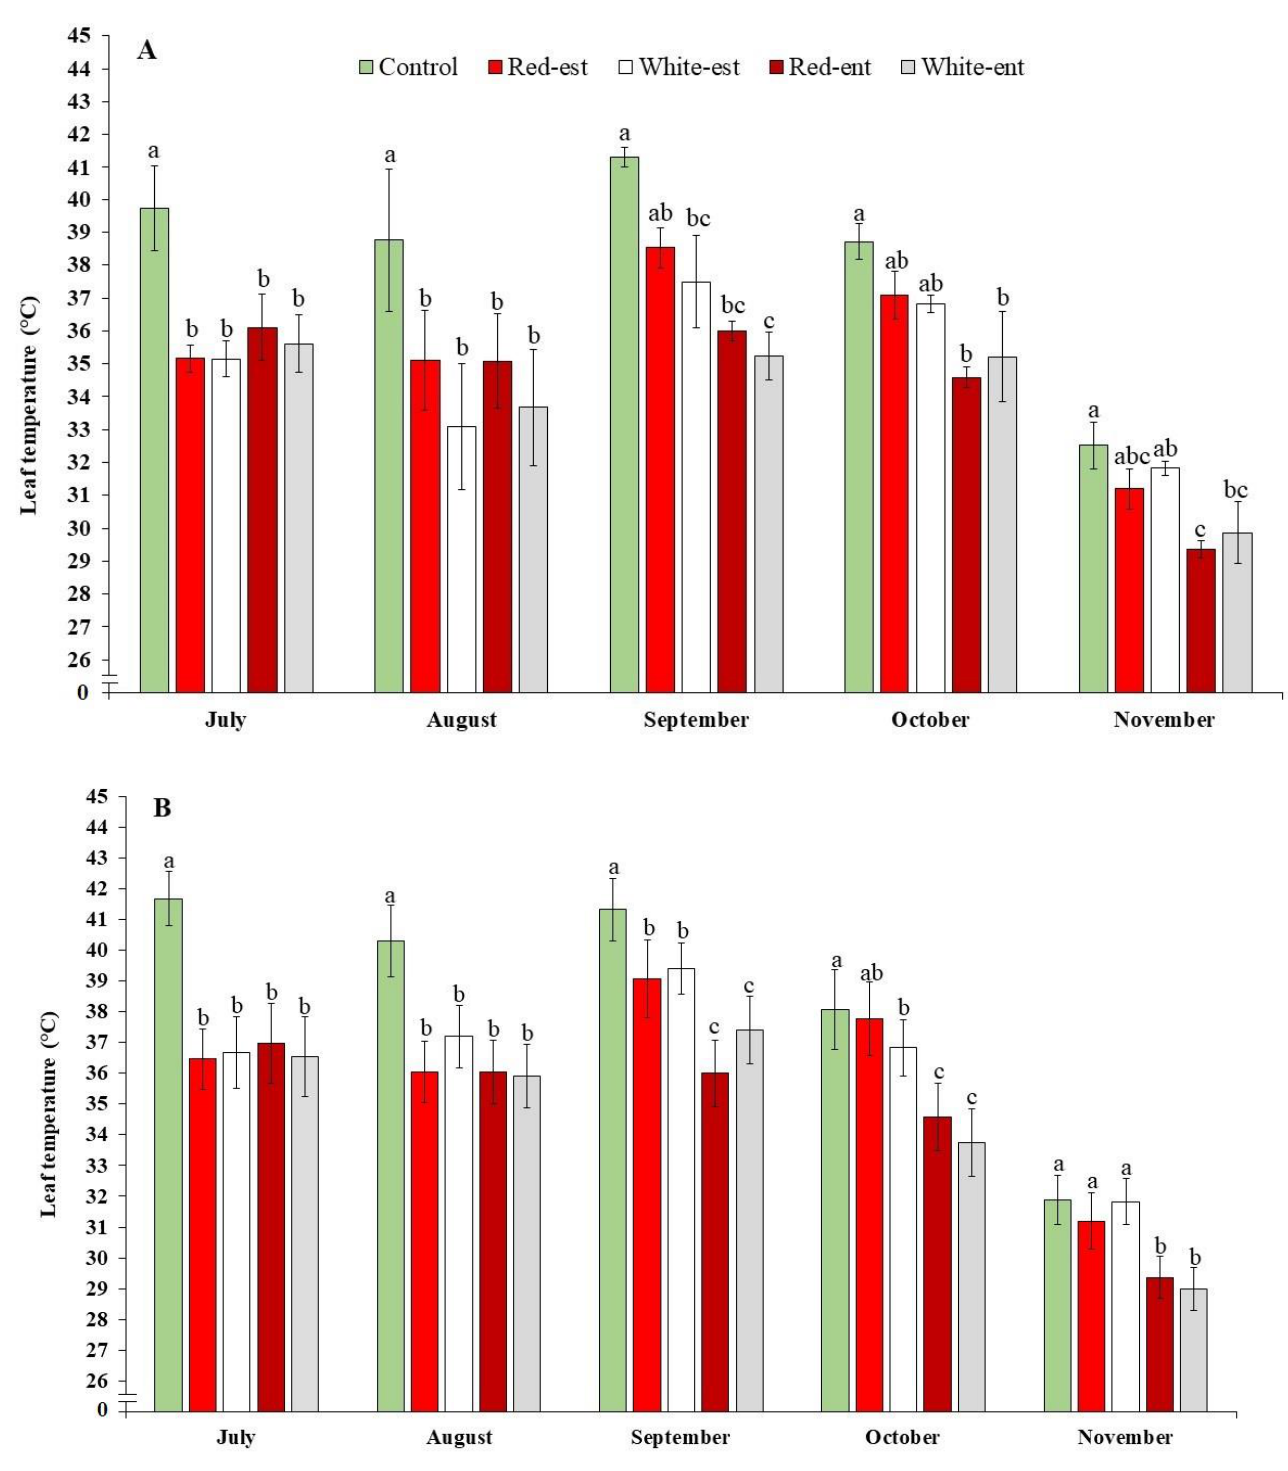
Figure 1. Average monthly leaf temperature measured in ginger ( A ) and turmeric ( B ) plants grown in an open field treated with white, red, or no kaolin sprays (control) during two production stages (early establishment vs. entire cycle) in Experiment 2. Red est and White est refer to kaolin with or without red dye, respectively, applied during early season establishment (four biweekly applications). Red ent and White ent refer to kaolin with or without red dye, respectively, applied during the entire growing cycle (ten biweekly applications). Bars represent means ± SE (n = 6). Different letters indicate statistical differences among treatments based on Tukey’s HSD test at p ≤ 0.05 (n =